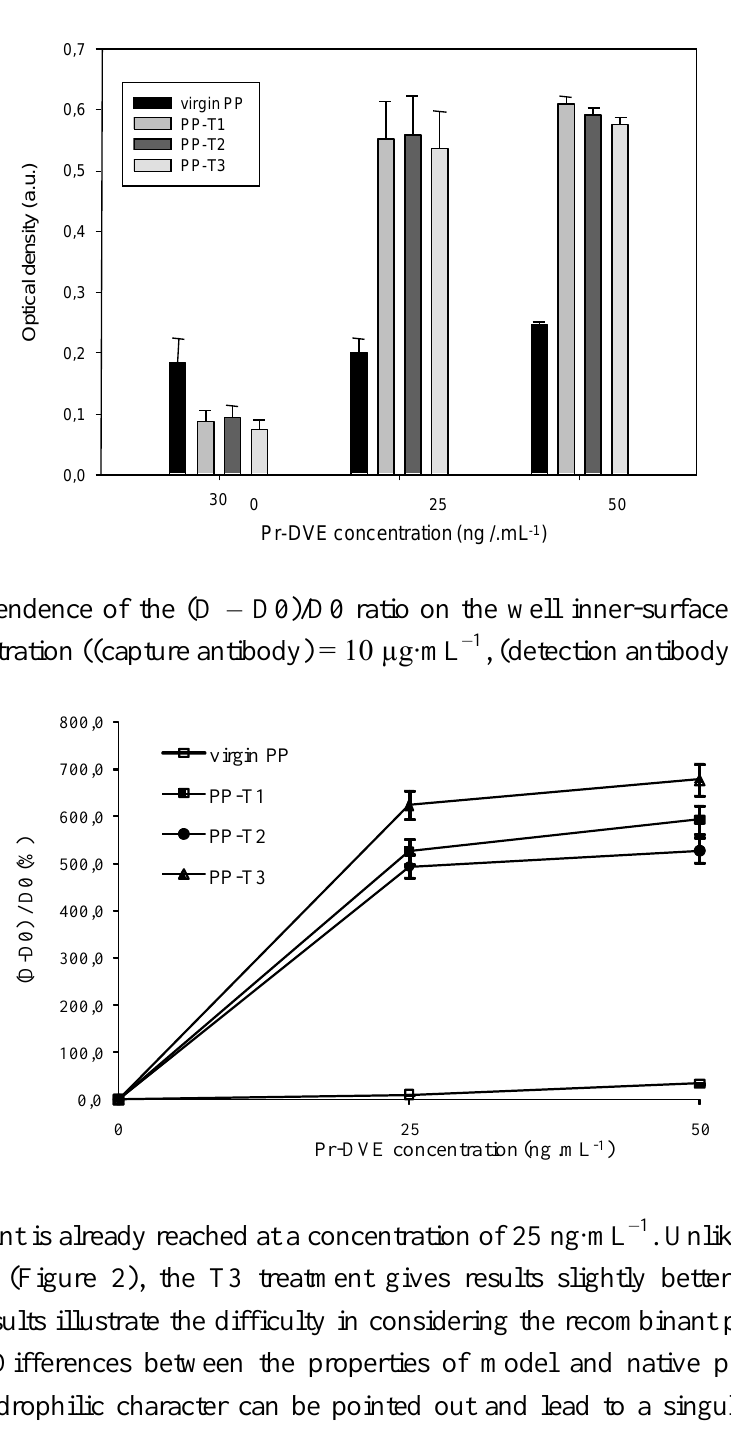
Figure 4. Dependence of the detection of Pr-DVE protein on its concentration and the well inner-surface nature ((capture antibody) = 10 µg∙mL –1 , (detection antibody) = 1 µg∙mL –1 ).